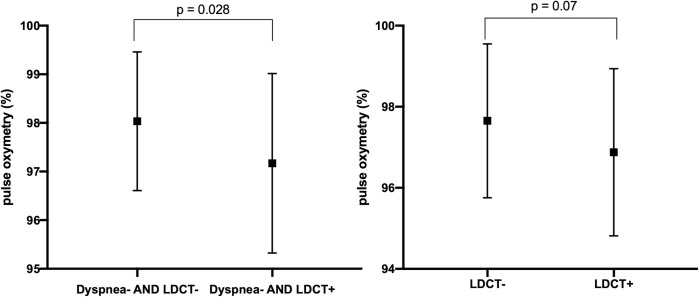
Pulse oxymetry according to LDCT and dyspnea.A significant difference was found between pneumonia and non pneumonia on LDCT concerning the oxymetry (p = 0.07) and between pneumonia and non pneumonia on LDCT among patient without dyspnea (p = 0.028). LDCT: low dose computed tomography.